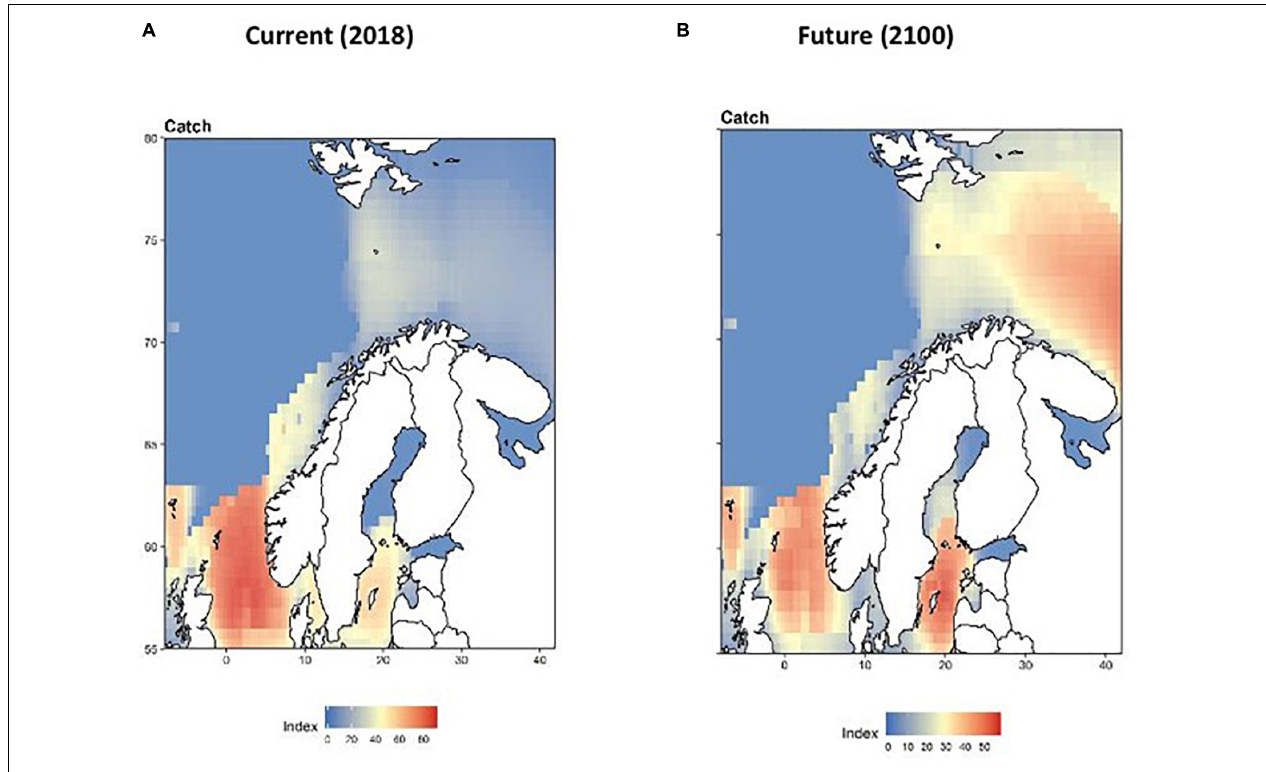
FIGURE 5 | The relative abundance of cod in the Northeast Atlantic region under (A) the current status (B) high greenhouse gas emission scenario (RCP8.5).